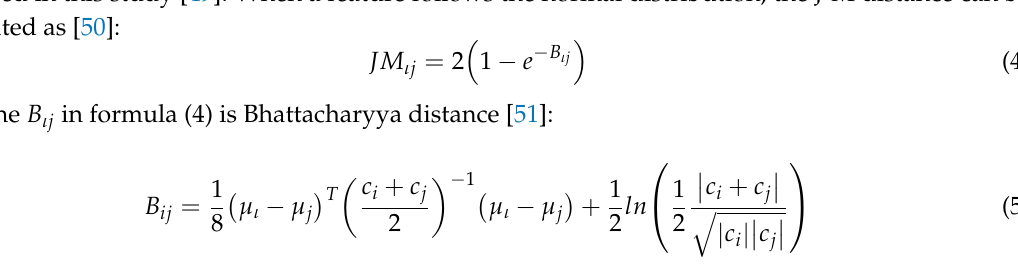
Table 7. Summary of classification schemes.